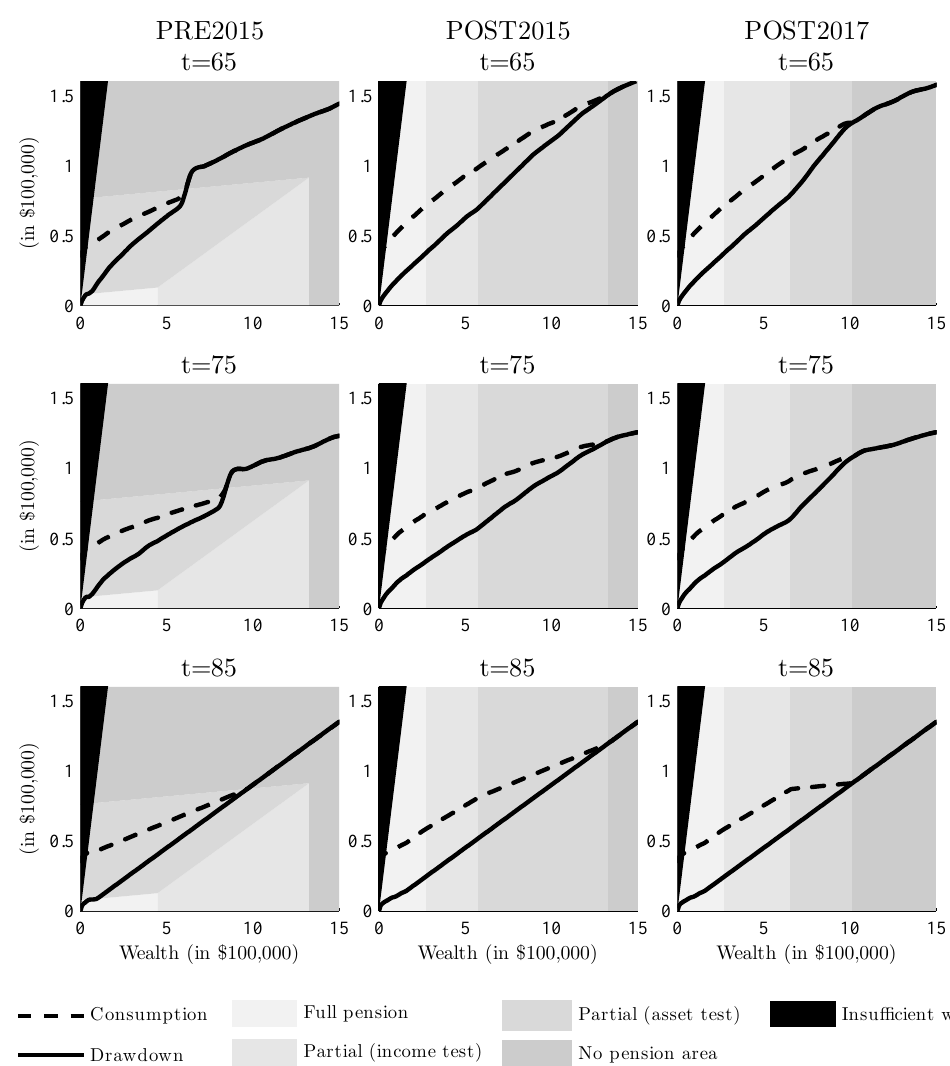
Figure 1. Optimal drawdown and consumption for non-homeowner couple households for a given liquid wealth at the age t , under the three different policy scenarios in the case of low returns ( µ =